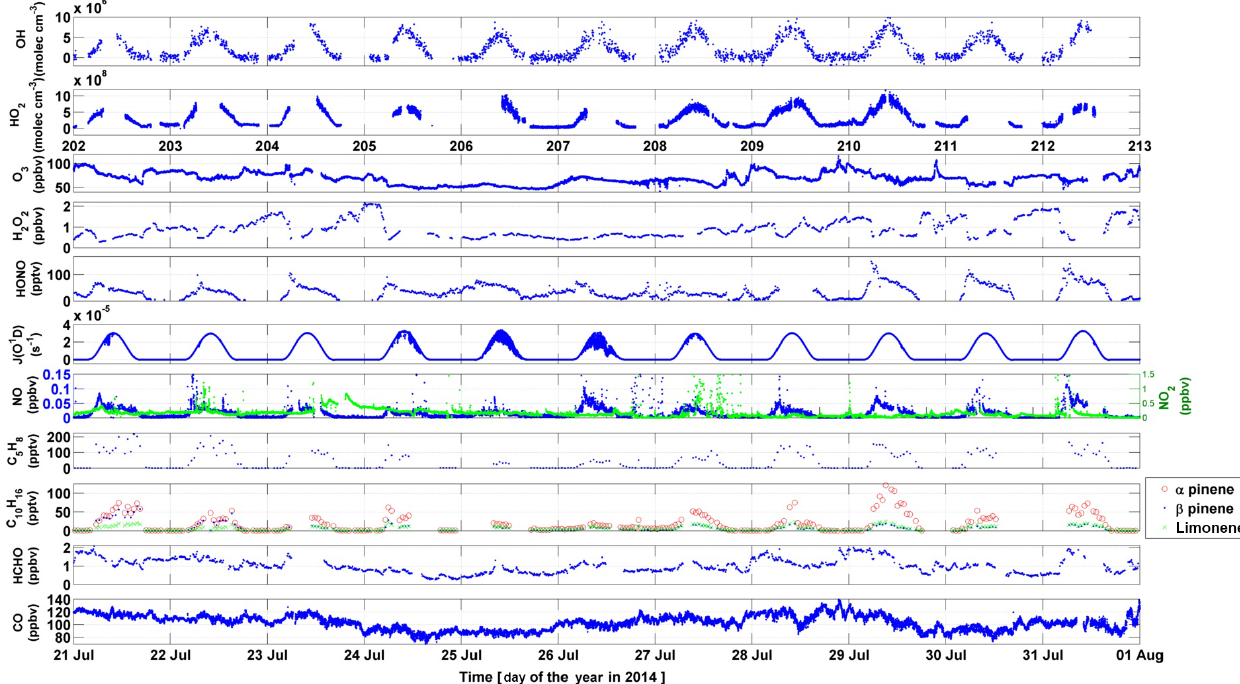
Figure 2. Measurements of OH, HO 2 , and selected chemical and radiation parameters relevant to HO x chemistry during the CYPHEX campaign. Time is in UTC. Local time in Cyprus during summer is UTC +